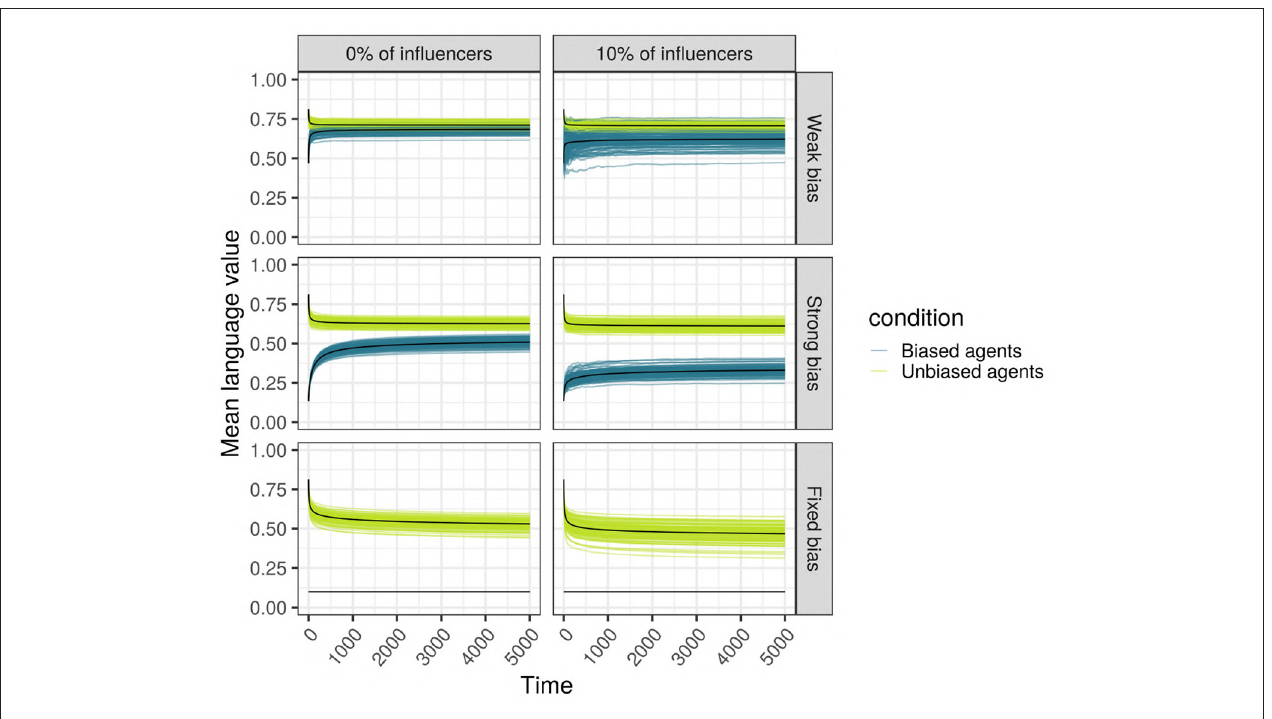
FIGURE 6 | Language (vertical axis, as language values) is changing across time (horizontal axis, in ticks) in a scale-free network with 500 SAM agents of which 10% are biased. Each individual curve represents the mean language value of the biased minority (purple) and the unbiased majority (light green) for 100 independent replications. Top: The minority is strongly biased; bottom: the minority is weakly biased. (Left) The biased minority is not overrepresented among the most influential agents in the network; (Right) the 10% most influential agents are occupied by biased